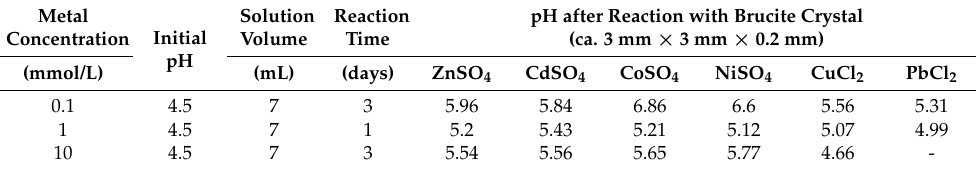
Table 2. Bulk pH values of metal solutions after reaction with brucite